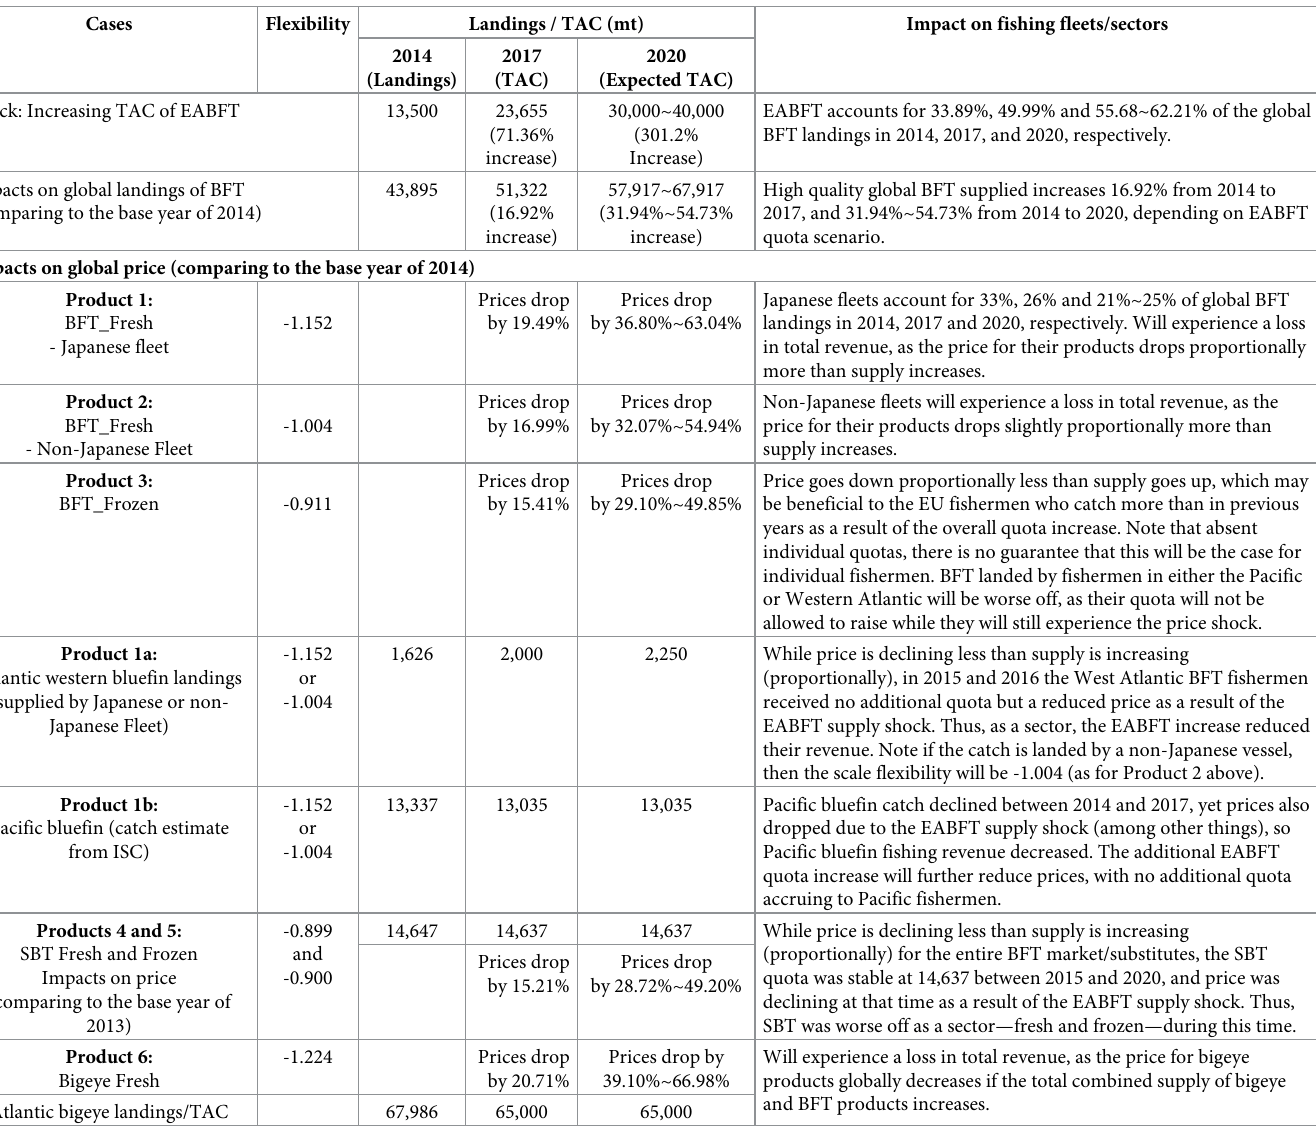
Table 6. Simulation of the price response analysis of the bluefin tuna auction market in Japan and on various fishing fleets/sectors based on the shock of TAC of EABFT on global landings of BFT in 2017 and expected changes in 2020 (comparing to the base year in